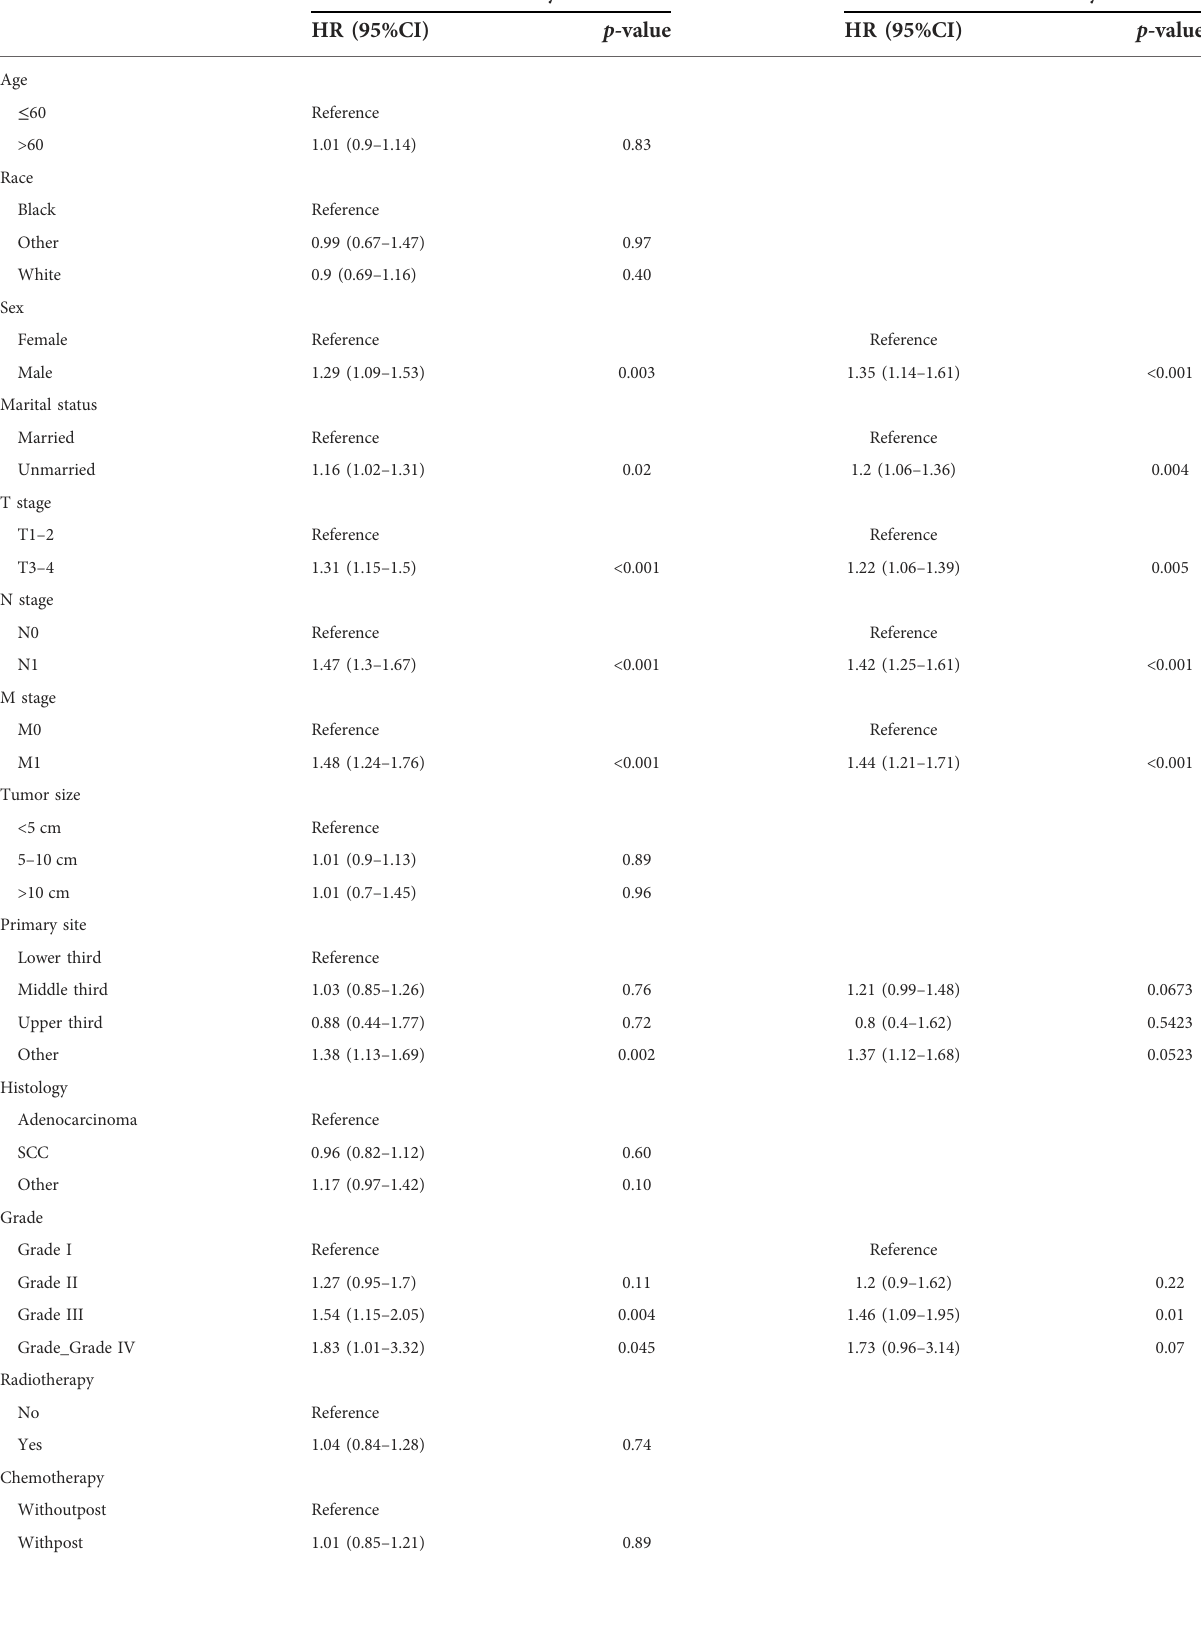
TABLE 2 Univariate and multivariate cox analysis of overall survival in EC patients with neoadjuvant